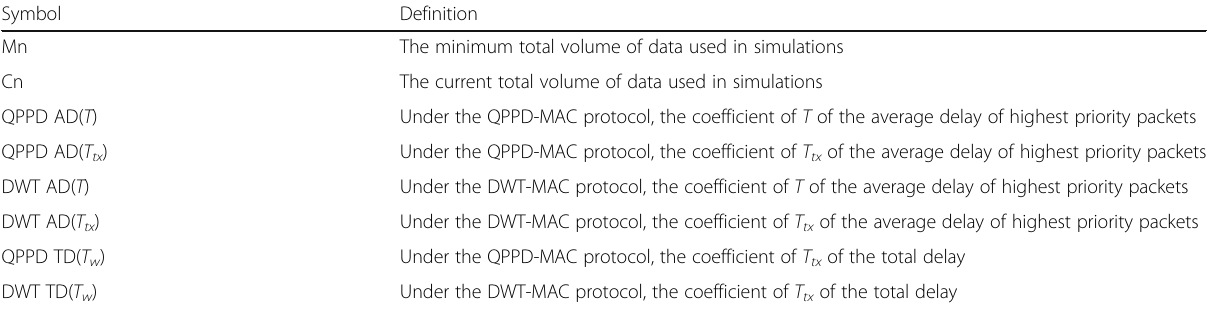
Table 5 Symbols used in simulations and their definitions